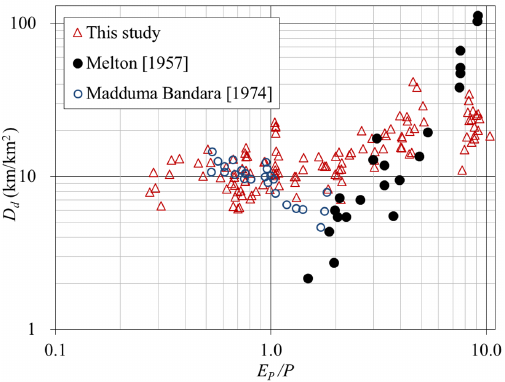
Figure 6. Drainage density ( D d ) versus climate aridity index ( 𝐸 (cid:3017) /𝑃 ) from Melton [33], Madduma Bandara [39], and this study.